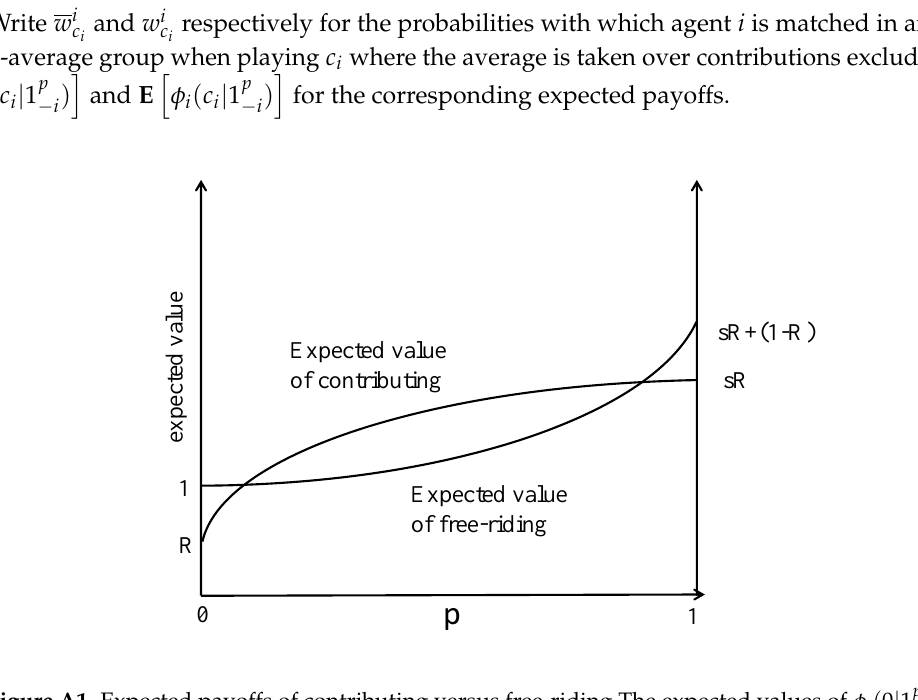
Figure A1. Expected payoffs of contributing versus free-riding.The expected values of φ i ( 0 | 1 p ) are plotted as functions of the probability p for some fixed β > β . The two planes intersect at φ i ( 1 | 1 p − i the bifurcating symmetric mixed-strategy Nash equilibrium-values of p and p (see Proposition A10). The relative slopes of the two curves illustrate the proposition. Note that this figure is a slice through Figure A2 along a value of β > β